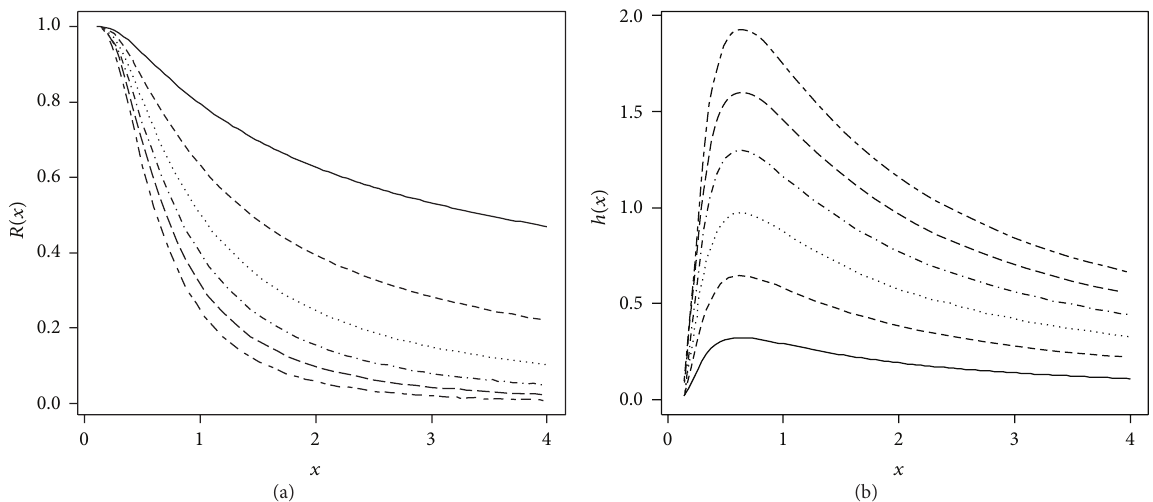
Figure2:Possibleshapesofthereliabilityfunction 𝑅(𝑥) (a)andhazardratefunction ℎ(𝑥) (b)oftheEGtype-2distributionforfixedparameter values of 𝜙, 𝜃 = 1 and selected values of 𝛼 parameter. 𝛼 = 0.5 (solid lines), 𝛼 = 1 (dashed lines), 𝛼 = 1.5 (dotted lines), 𝛼 = 2 (dot-dashed lines), 𝛼 = 2.5 (long dashed lines), and 𝛼 = 3 (two dashed